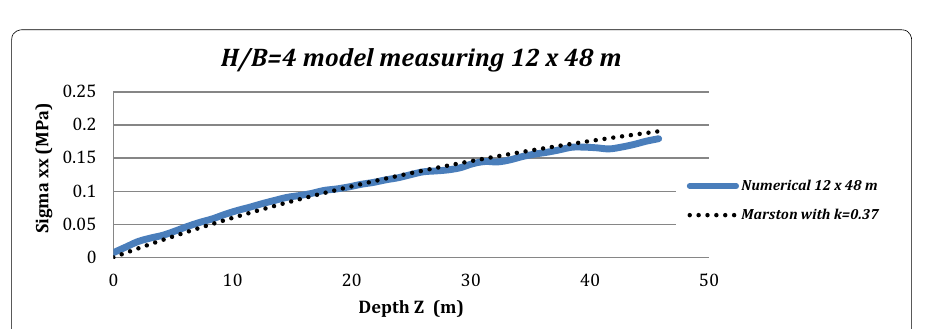
Fig. 15 Adjustment of the Marston model with backfill measuring 12 chanical parameters: φ ′